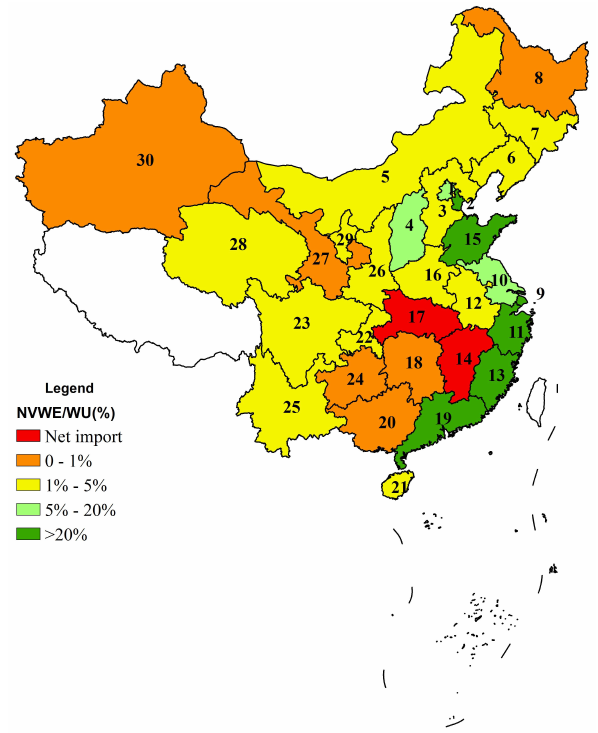
Fig. 5. Share of net virtual water export in total water use in differ- ent provinces